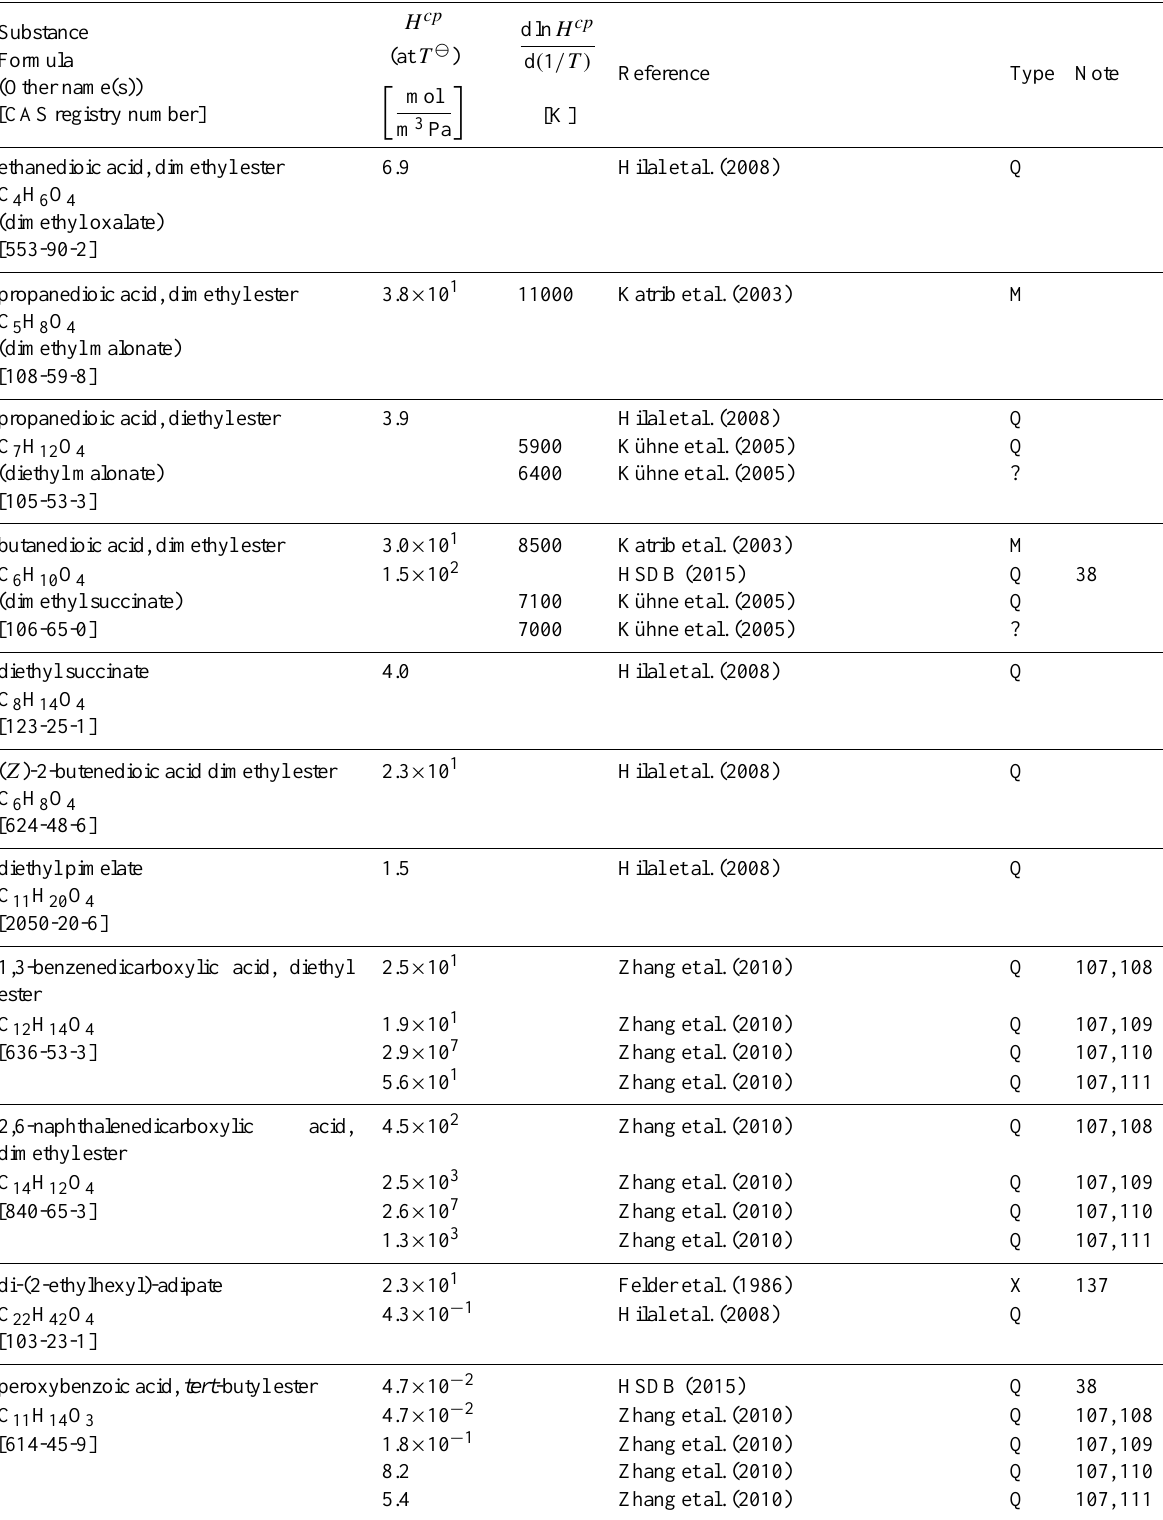
Table 6: Henry’s law constants for water as solvent